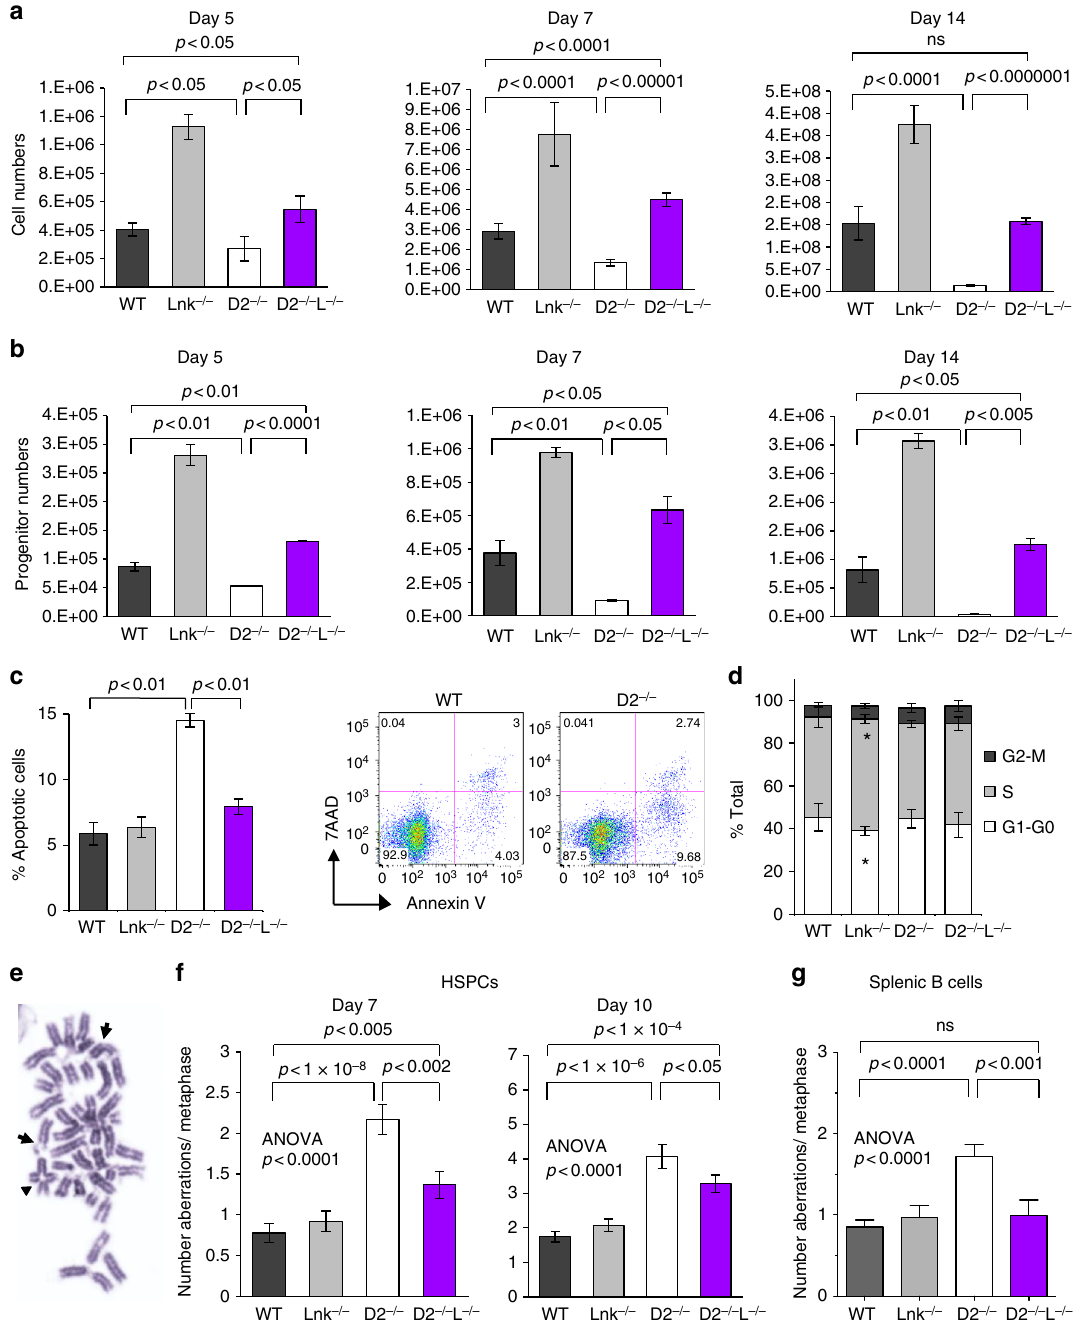
Fig. 4 Lnk de fi ciency rescues the growth and survival defect of Fancd2 − / − HSPCs and mitigates genome instability. a , b HSPCs were cultured in TPO and SCF containing media for 14 days. One representative experiment of three independent replicates is shown. a Cumulative cell growth at days 5, 7, and 14 is shown. b At each corresponding day of culture, cells were plated for quanti fi cation of colony forming progenitors. Cumulative progenitor cell numbers were calculated and plotted. P values indicate two-tailed Student ’ s t -test. c On day 7, percentage of apoptotic cells was assessed by Annexin V + /7-AAD- cells and quanti fi ed. The right shows representative fl ow plots of Annexin V/7-AAD staining. d Quanti fi cation of cell cycle status in HSPCs using Ki67 and DAPI after 7 days in culture. Bars indicate mean and error bars indicate SE. * p < 0.05 compared to WT, Student ’ s t -test. e , f BM HSPCs cultured for 7 or 10 days in cytokines were assessed for chromosomal aberrations. e shows examples of chromosomal breaks (arrows) and radial chromosomes (arrowhead) scored on metaphase spreads. g Splenic B cells cultured for three days were assessed for chromosomal aberrations. f , g Quanti fi cations of mean aberrations for 100 – 150 metaphase spreads from 4 – 6 animals are shown, and error bars indicate SE. Comparisons among all four genotypes were calculated by one-way ANOVA and are shown for each graph. p values using Tukey ’ s t -test for each indicated comparison pair are shown. Representative data from